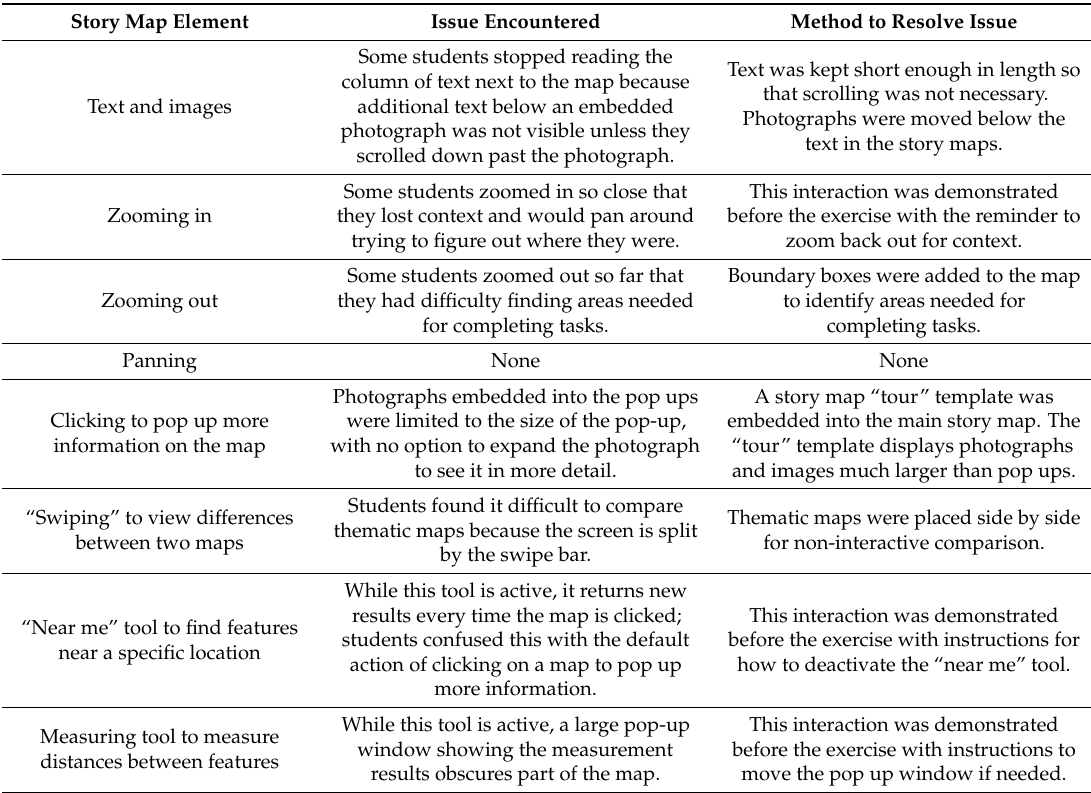
Table 1. Issues with story map design identified during preliminary assessment and methods used to resolve